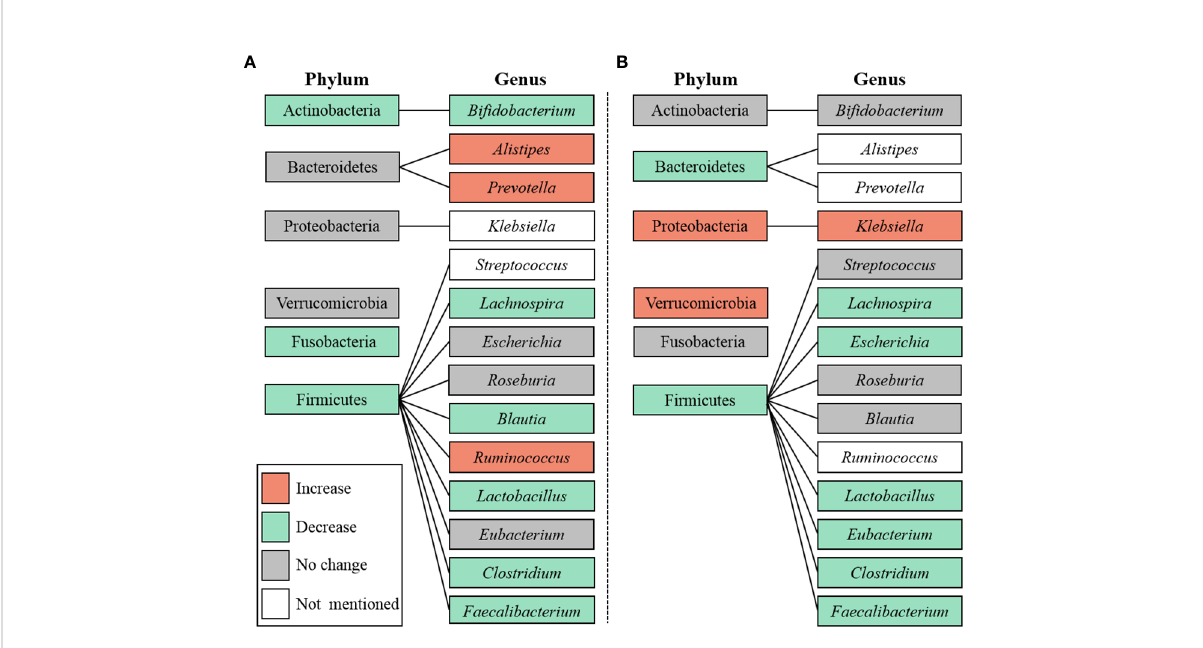
FIGURE 8 Microbiota at the phylum and genus level. (A) DC v.s. DM; (B) DC v.s.